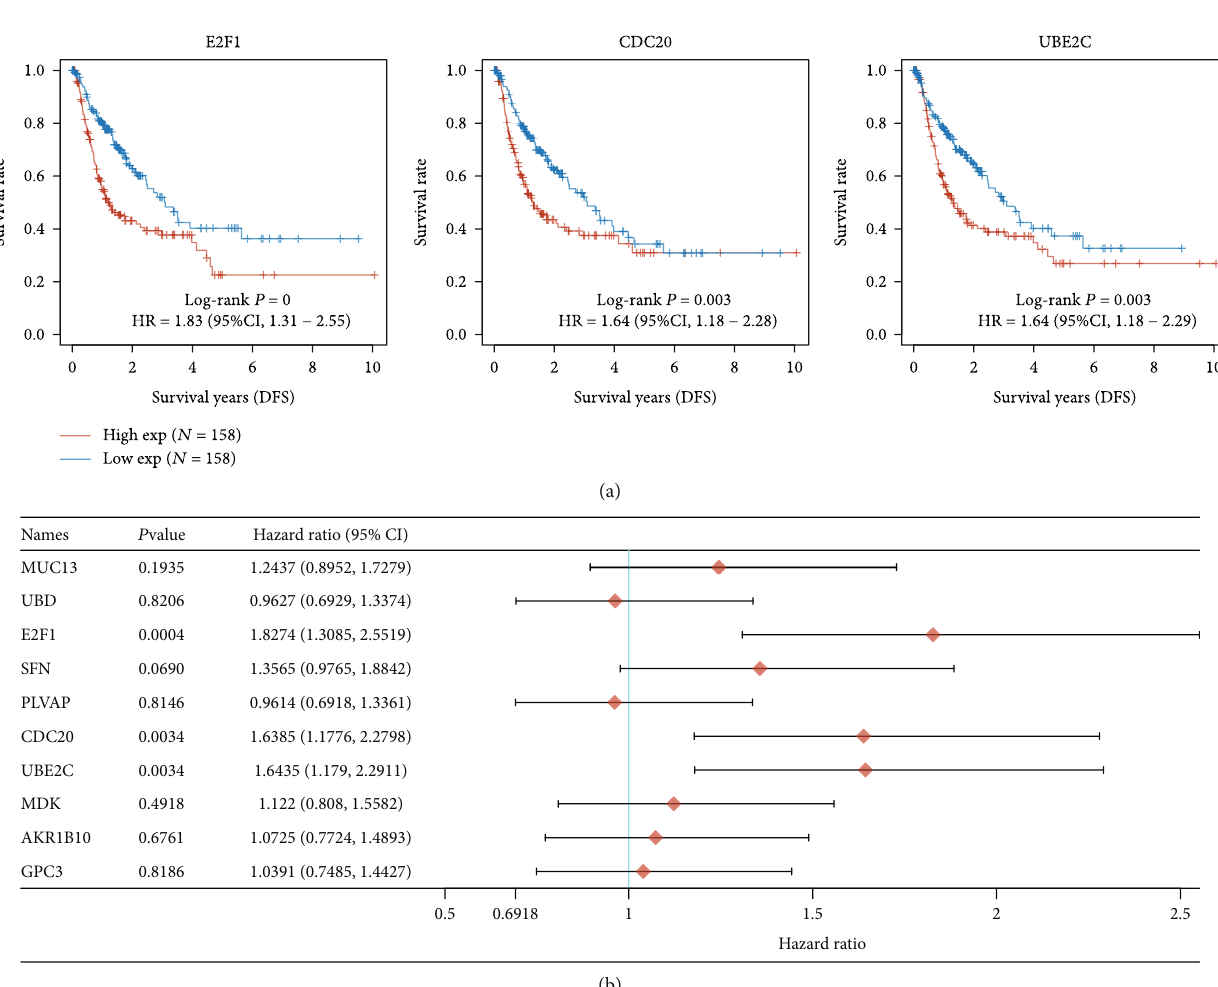
Figure 4: Identi fi cation of disease-free genes having a correlation with survival in HCC using the top 10 overexpressed genes. (a) E2F1, CDC20, and UBE2C were identi fi ed to be high risk factors via Kaplan-Meier tests. (b) Univariate Cox regression